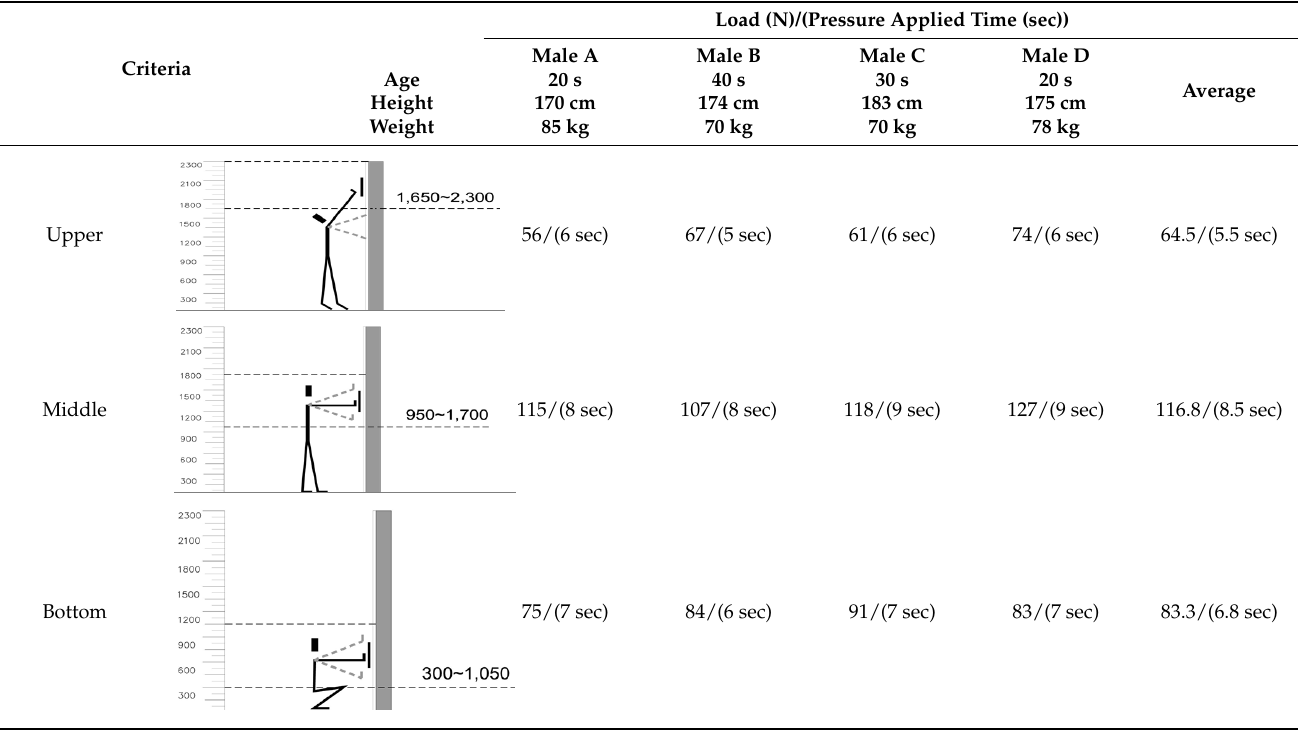
Table 4. Tile application pressure derivation testing results.